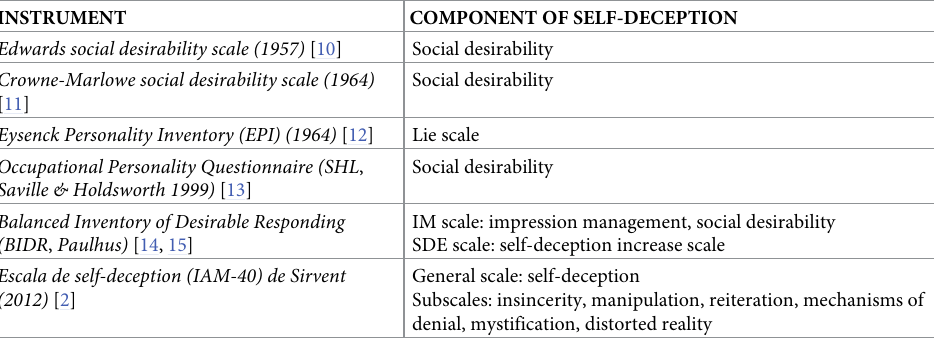
Table 1. Instruments measuring the various components of